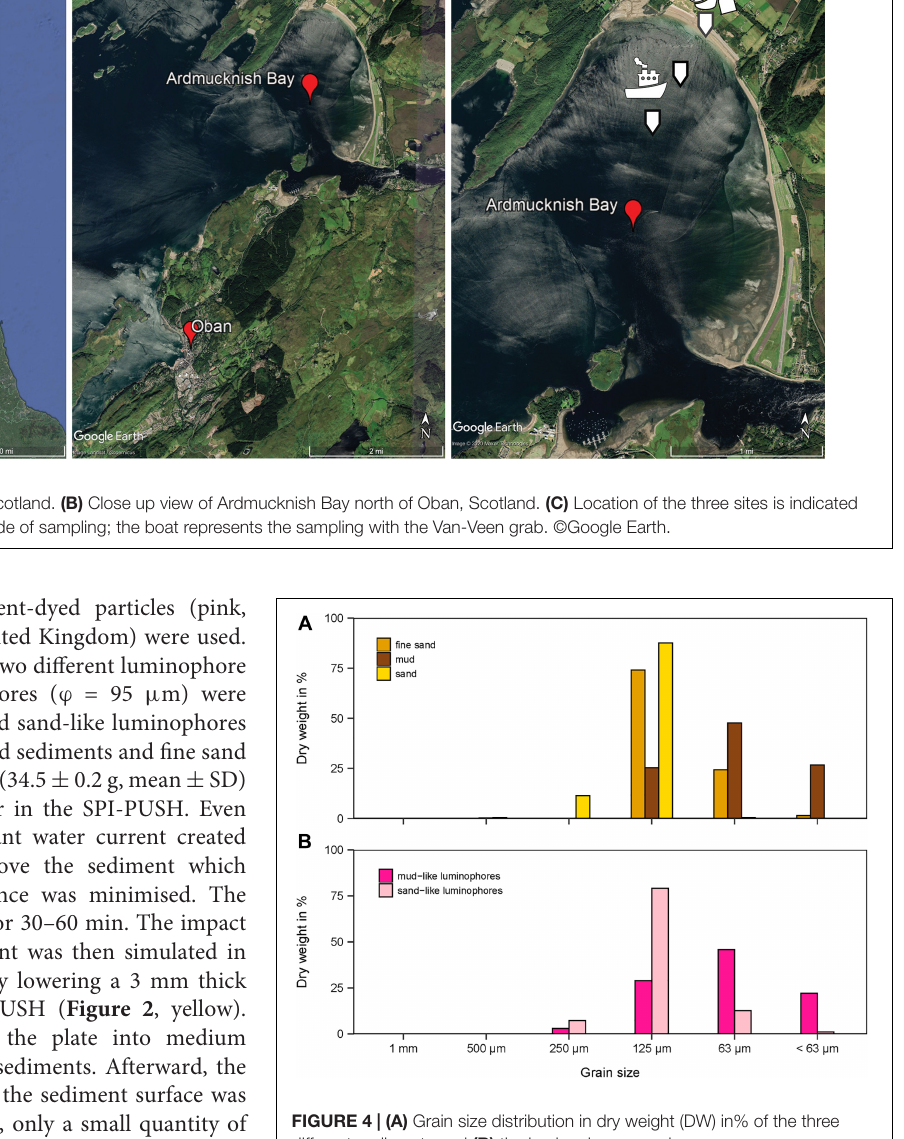
Smearing Directly at the Plate Smearing of luminophores directly at the plate was photographed using a Canon EOS 50D camera (Canon EF 50 mm, f/1.8 STM Lens, with UV blocking filter) under UV light (BeamZ Flatpar 186 UV, 35 W). The height of the sediment surface from the base of the SPI-PUSH was averaged as it was not a uniform, flat surface. To do this, the width of the visible sediment column was divided into 1-cm sections, and the depths where luminophores were present was recorded for each section ( Figure 5 ). For each experiment, 10 luminophore depth measurements were taken, and the mean and standard deviation were calculated ( Figure 5